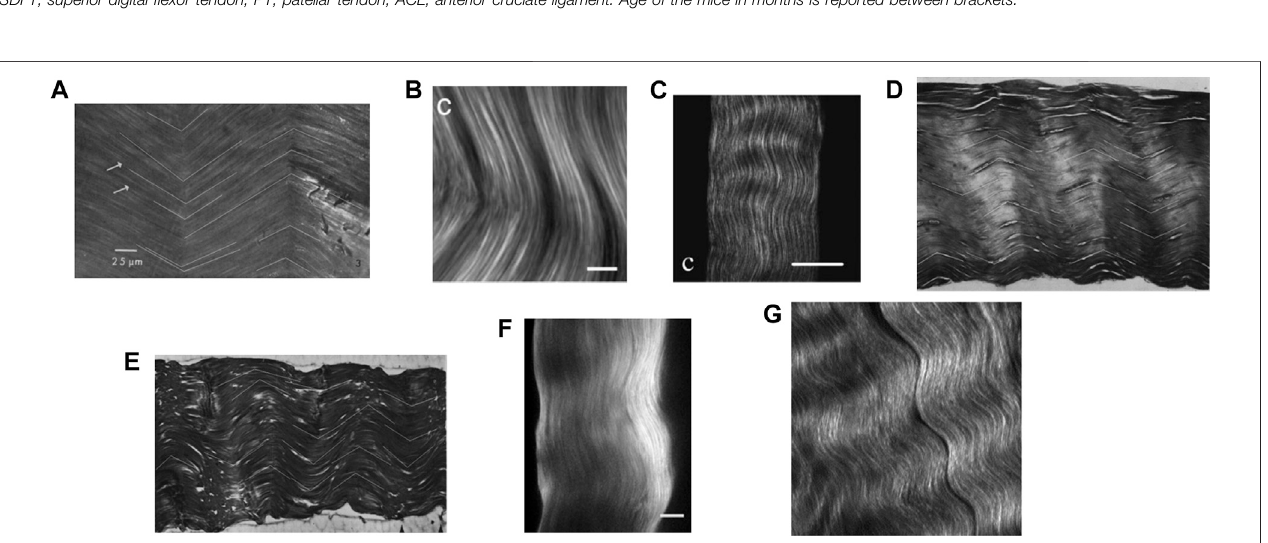
FIGURE 4 | Microscopic images of tendinous tissue: (A) rat tail tendon in transmitted light, copied from the Figure 3 copied from (Dlugosz et al., 1978), copyright grantedbyElsevierLTD,scalebar:25microns; (B) forwardsecondharmonicgeneration(SHG)imageofamatureSprague-Dawleyrattailtendon,copiedfromtheFigure 5C of (Williams et al., 2005), copyright granted by Elsevier LTD, scale bar: 10 microns; (C) SHG polarization from individual bundles analyzed with an analyzer oriented paralleltotherattailtendon bundle,copiedfromtheFigure2Cof(Williamsetal.,2005),copyrightgranted byElsevierLTD,scalebar:50microns; (D , E) histological longitudinal-sectionsofarattailtendon fascicle,copiedfromtheFigures4A,Bof(Nivenetal.,1982),copyrightgrantedbyElsevierLTD,respectiveimagewidth:530and 740 microns; (F) SHG imaging of the rat tail tendon fascicle microstructure after few cycles preconditioning, copied from Figure 2C of (Goulam Houssen et al., 2011), copyright granted by Elsevier LTD, scale bar: 50 microns; (G) porcine knee posterior cruciate ligament SHG image, copied from Figure 3 of (Lee et al., 2017), copyright granted by SPIE and agreement from the corresponding author, image width: 90